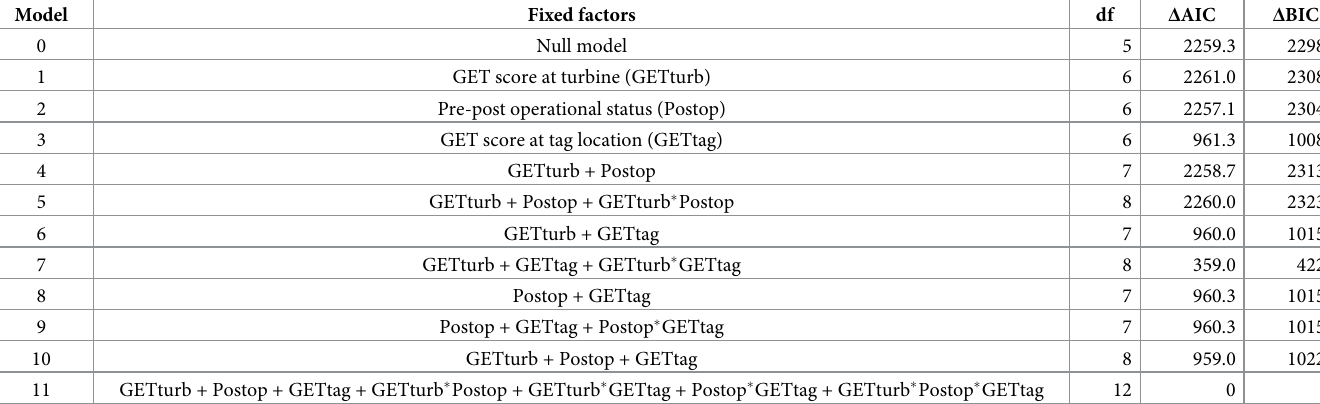
Table 1. The twelve model candidates in before-and-after-operation GLMMs with resultant model selection values of Δ AIC and Δ BIC.